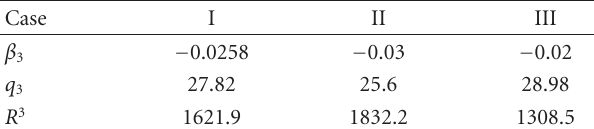
Table 5: Quantization parameter and bitrate for sequence football